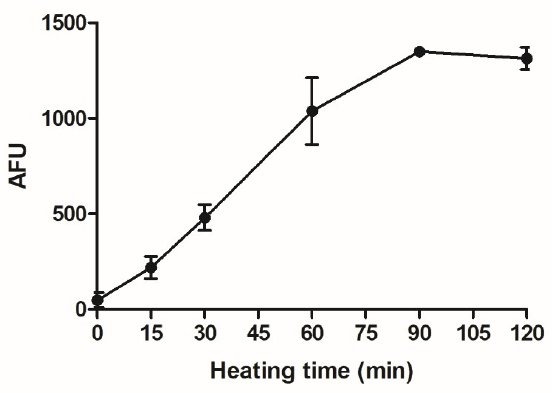
Figure 1. AGE-specific fluorescence of glycated casein measured at λ ex = 370 nm/λ em = 440 nm in relation to the heating time of the three components casein from bovine milk (10 g/L), lactose (0.2 M) and glucose (11 mM). Values were corrected for baseline fluorescence and data are shown as mean ± SD, n = 3.